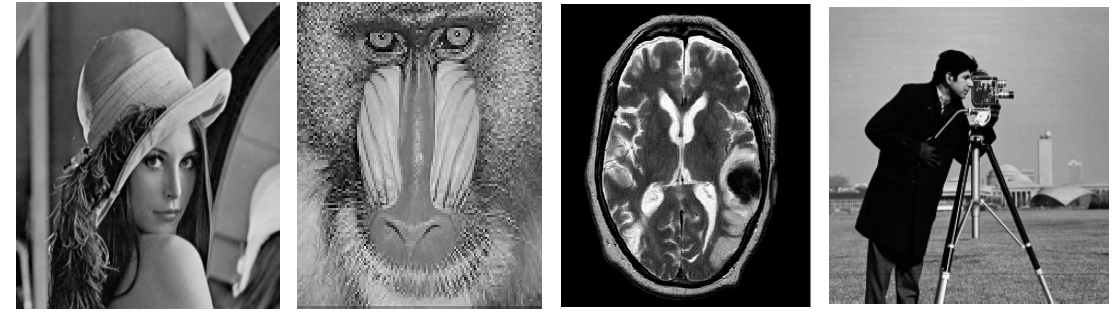
Figure 5. Original dataset.